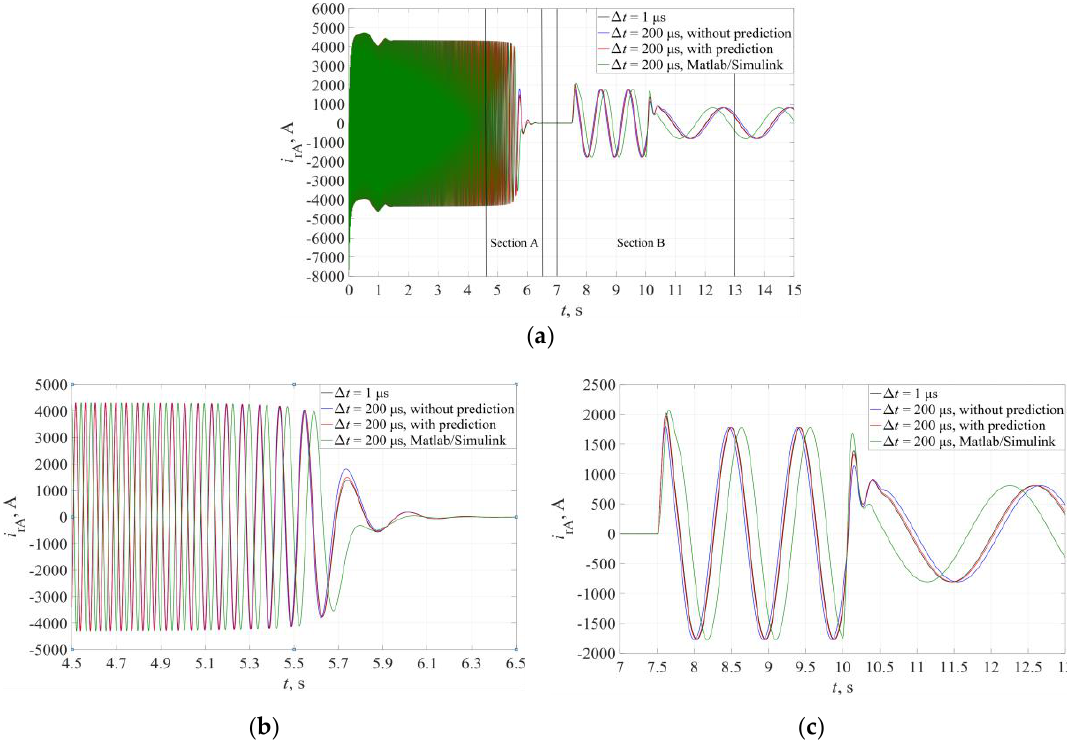
Figure 10. Rotor current waveforms ( a ) in phase A from simulation experiments (two sections are marked, which are shown in detail in ( b ) section A and ( c ) section B).